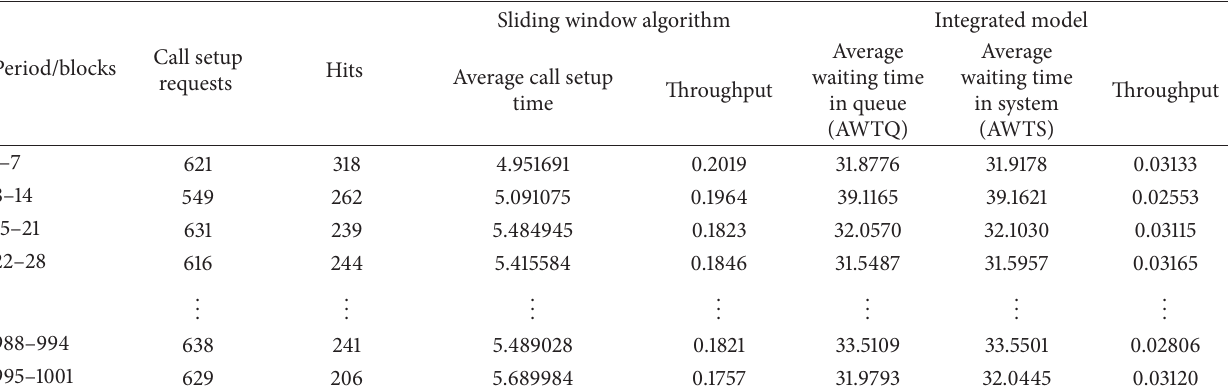
Table 3: Aggregated simulation results for each block.